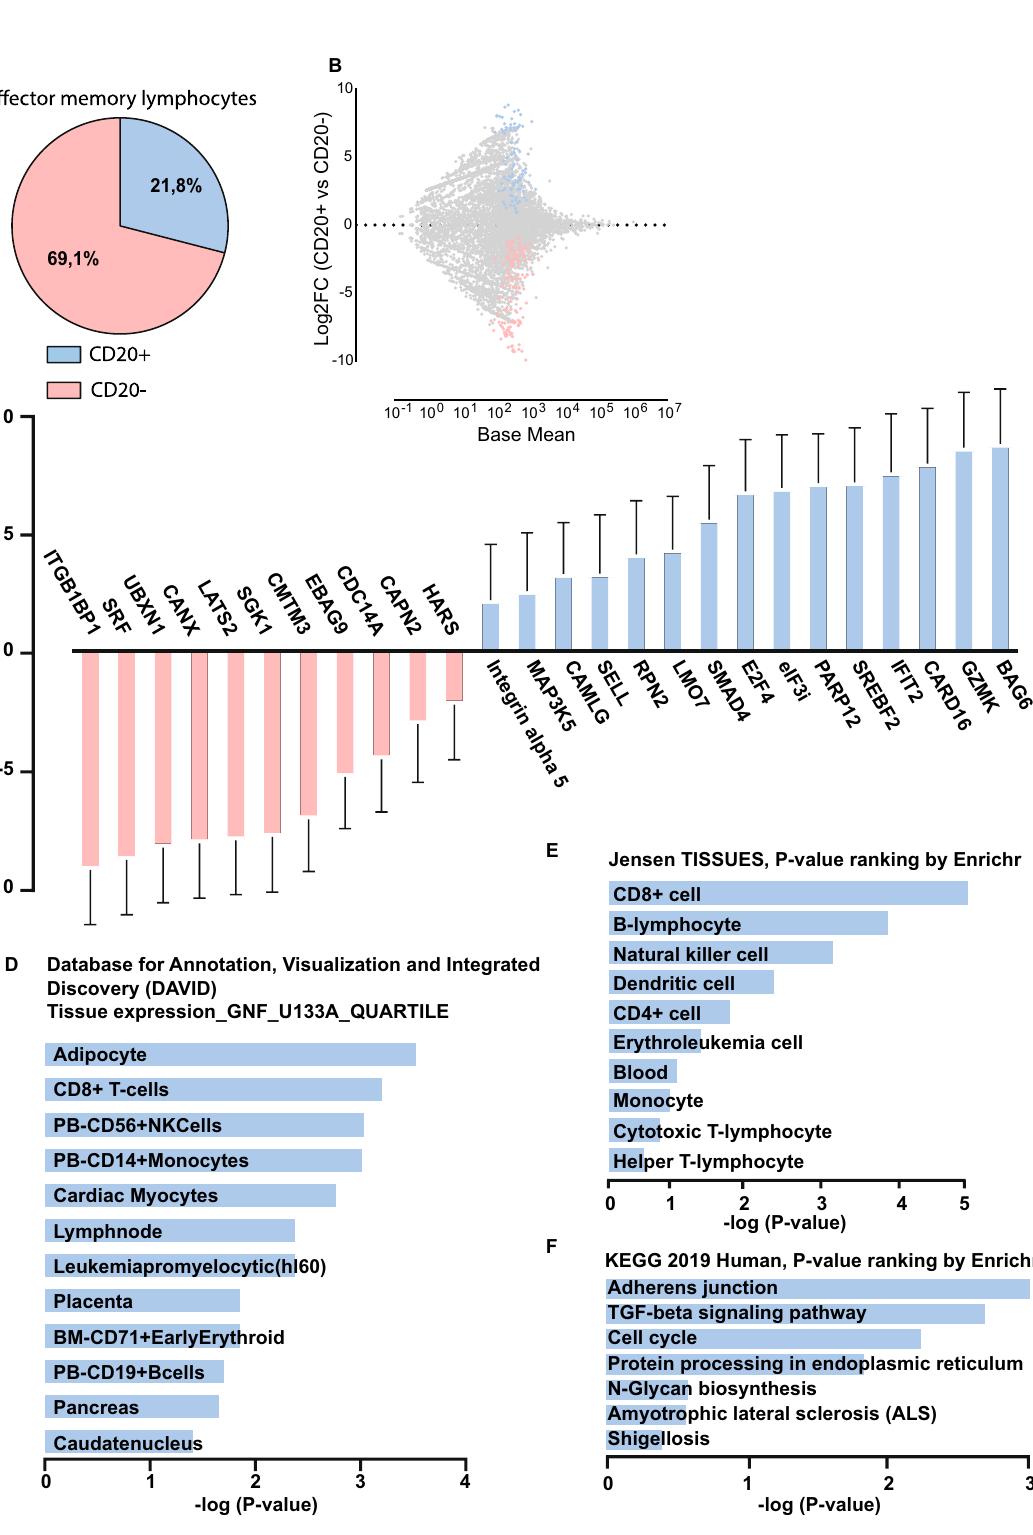
Figure 2. RNAseq analysis of CD20 + effector memory T cells reveals an altered transmigration and adhesive profile combined with an enhanced activation status. ( A ) Pie chart displaying FACS analysis of CD20 + T cells in a effector memory lymphocytes subset. ( B ) MA plot displaying DEGs in CD20 + CD3 + CD8 + CD45RO + CCR7- versus CD20- CD3 + CD8 + CD45RO + CCR7- with significantly upregulated genes in blue and significantly downregulated genes in red. DEGs were determined by DESeq2 (Wald test and corrected for multiple testing using the Benjamini and Hochberg method). Genes with a Benjamini–Hochberg FDR < 0.05 and log2FoldChange ≥ 2 were selected for further analysis. ( C ) log2FoldChange of a subset of significantly DEGs, with standard error (L2fcSE), with activation/memory/cytotoxic/migratory/adhesive backgrounds. ( D ) Search of DEGs for enriched terms using the tissue expression library (GNF U133A quartile) of the Database for Annotation, Visualization and Integrated Discovery (DAVID), ( E ) using the Jensen TISSUES library of Enrichr (P-value ranking) and ( F ) using the KEGG 2019 human pahtway of Enrichr (P-value